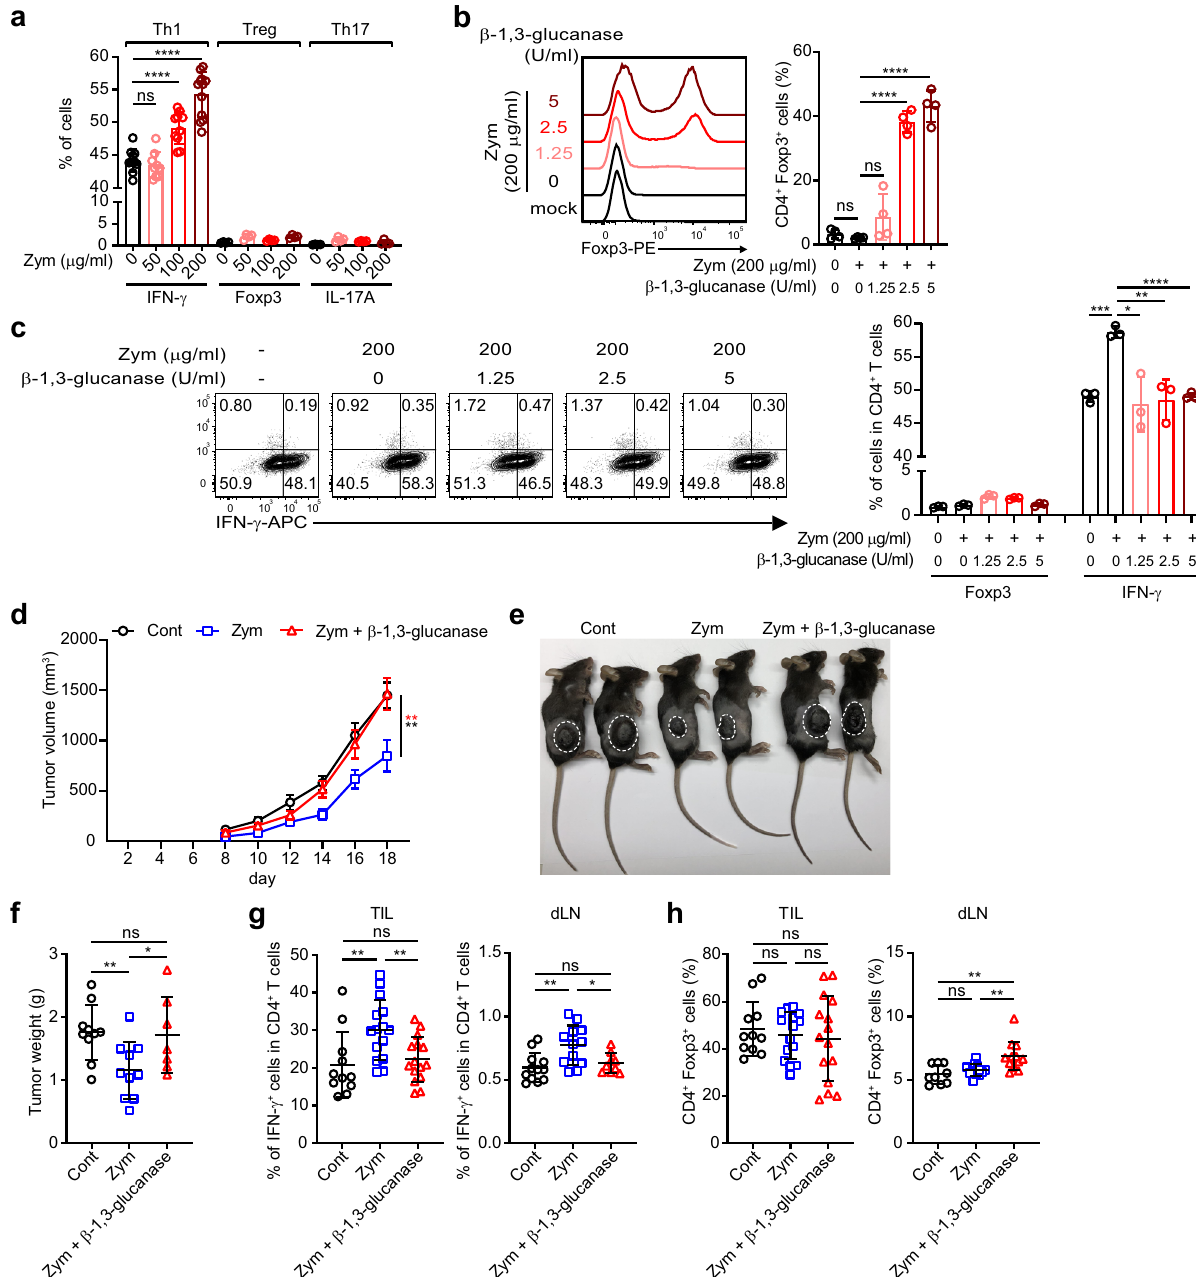
Fig. 1 β -1,3-Glucan of zymosan enhances Th1 immune response and restrains Treg cell differentiation. a – c Splenic CD11c + DCs were stimulated with zymosan in the presence or absence of zymolase, which has β -1,3-glucanase activity, and cultured with naive CD4 + T cells under indicated T helper cell skewing conditions with suboptimal amounts of respective cytokines. a Frequencies of IFN- γ , Foxp3, and IL-17A producing cells under respective CD4 T-cell skewing conditions. Results are analyzed from 4 independent experiments with minimum 9 samples (IFN- γ ) and 2 independent experiments with 4 samples (Foxp3 and IL-17A). Representative fl ow cytometric plots (left panels) and frequencies (right panels) of Treg ( b ) and Th1 cells ( c ) induced under Treg or Th1 inducing conditions are shown. Each dot represents an individual sample. Results are analyzed with pooled data of 2 samples over 2 independent experiments ( b ) or 2 biologically independent experiments for which representative data is shown ( c ). The graphs show mean ± SD. * p < 0.05, ** p < 0.01, *** p < 0.001, **** p < 0.0001 (two-tailed student ’ s t test). d – h Mice were grafted with 2 × 10 5 cells of B16.F10 melanoma subcutaneously, followed by injection of zymosan or zymosan devoid of β -1,3-glucan every alternate day. Tumor growth ( d , e ) and tumor weight ( f ) were measured. Frequency of CD4 + IFN- γ + T cells was analyzed ( g ) among tumor in fi ltrated lymphocytes (TILs) and tumor-draining lymph nodes (dLNs). CD4 + Foxp3 + T-cell frequency ( h ) was analyzed in TILs and dLNs. Tumor growth result is analyzed with minimum 9 individual mice from 2 independent experiments. Tumor weight was measured with minimum 7 mice from 2 independent experiments. Result of CD4 + IFN- γ + T and CD4 + Foxp3 + T cell in TIL and dLNs were analyzed with minimum 9 mice from 2 independent experiments. Each dot represents an individual mouse. Graphs show mean ± SEM. d ** p < 0.01 or SD, f – h * p < 0.05, ** p < 0.01 (two-tailed student ’ s t test). ns: not signi fi cant. Source data are provided as a Source data fi